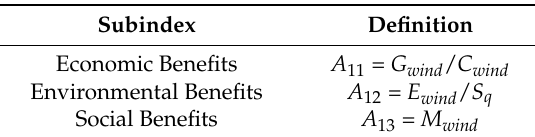
Table 1. Definition of